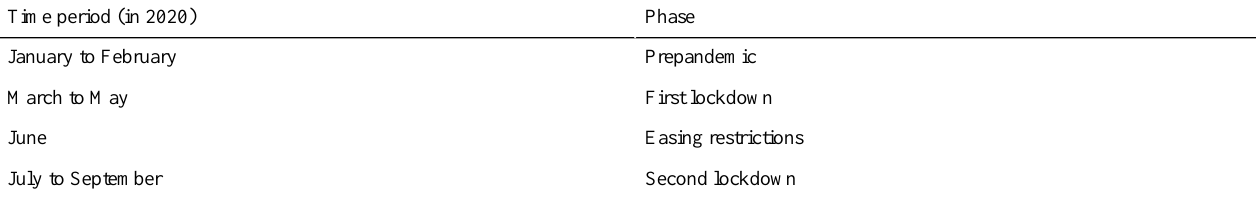
Table 1. The four main phases of the COVID-19 pandemic from January to September